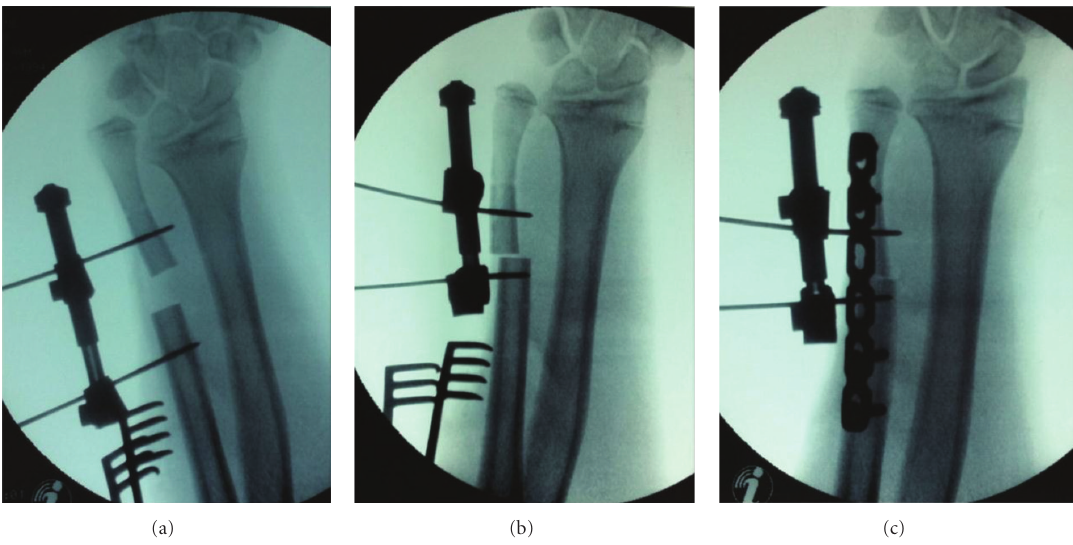
Figure 2: Intraoperative screening radiographs demonstrating (a) ulnar osteotomy with external fixator in situ, (b) reduction of the osteotomy bone ends, note the deformation of the Kirschner wires, (c) fixation of the osteotomy with a